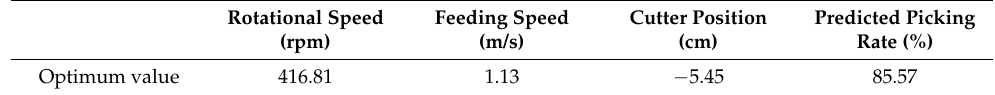
Table 6. Results of parameter